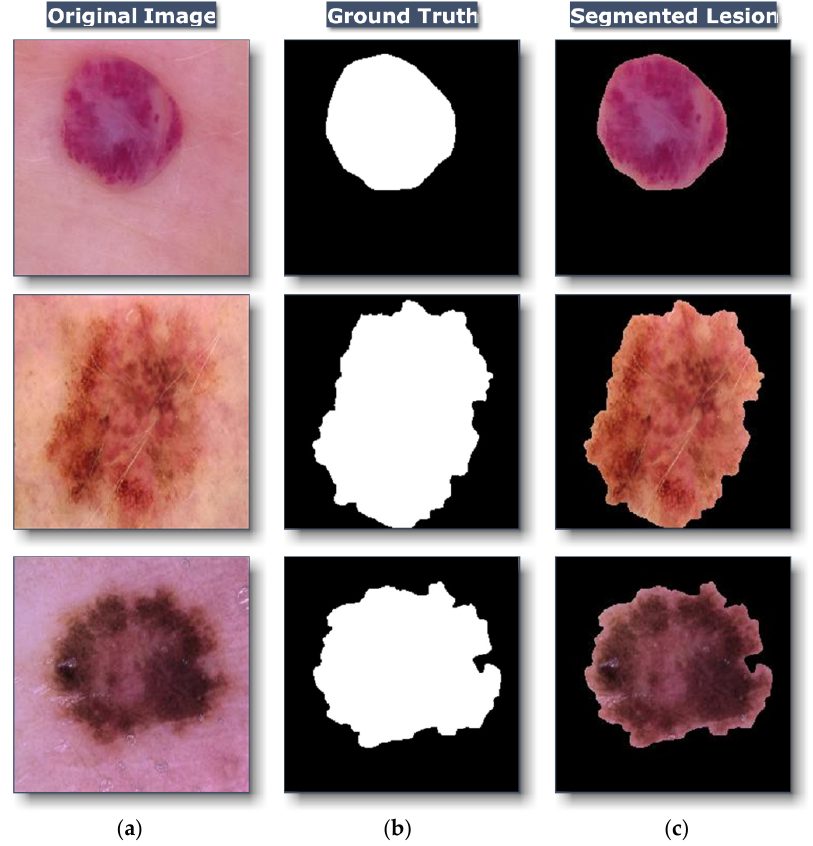
Figure 5. Samples of ( a ) original Image, ( b ) ground truth, and ( c ) the segmented